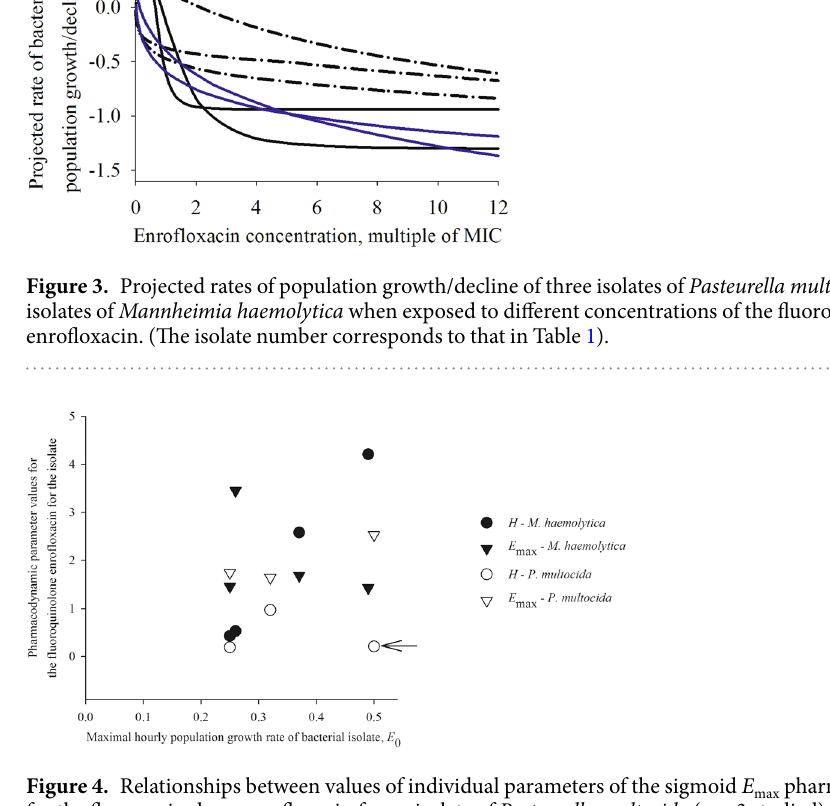
Figure 4. Relationships between values of individual parameters of the sigmoid E max pharmacodynamic model for the fluoroquinolone enrofloxacin for an isolate of Pasteurella multocida ( n = 3 studied) or Mannheimia haemolytica ( n = 4 studied). Solid black symbols denote the data-points for M . haemolytica and white with black edge symbols the data-points for P . multocida . E - bacterial population growth rate in the absence of 0 antimicrobial exposure. E - maximal decline of the bacterial population growth rate when exposed to the max antimicrobial. H – Hill-coefficient reflecting steepness of the relationship between an increase in the antimicrobial concentration and an increase in the decline of the bacterial population growth rate. The arrow identifies the outlier isolate in terms of the hypothesized relationship of H increasing with a higher E 0